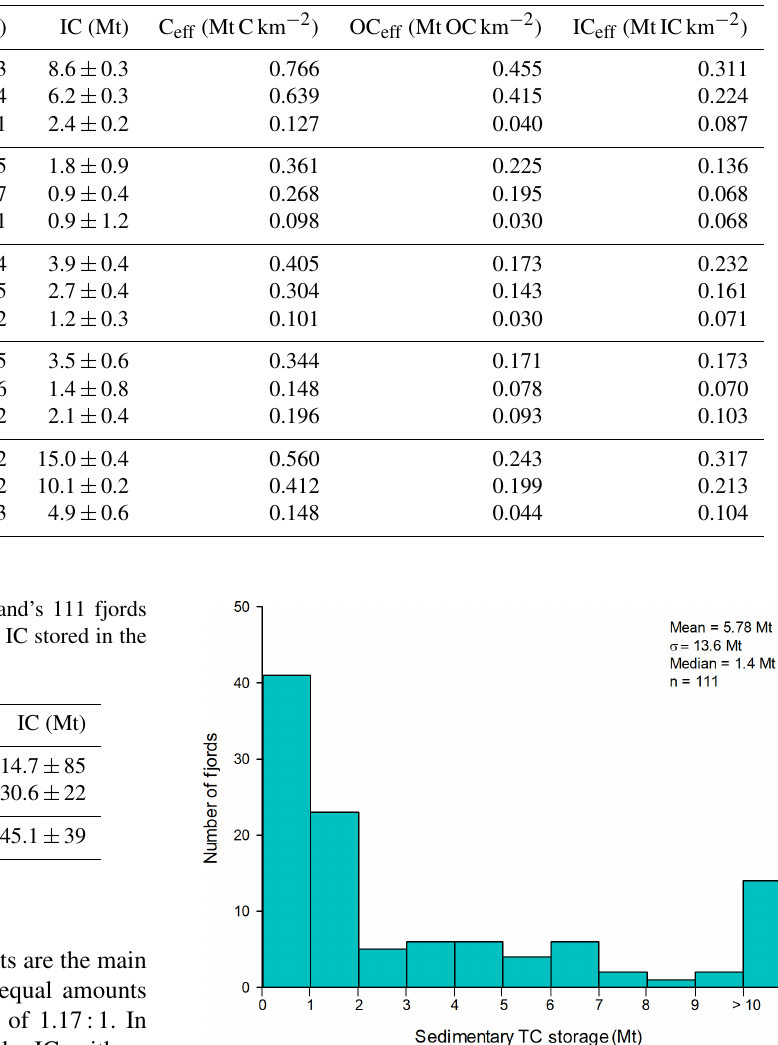
Table 2. Detailed sedimentary C stocks presented as total carbon (TC), organic carbon (OC) and inorganic carbon (IC) held within the postglacial (PG) and glacial (G) sediment of the fjords. Additionally, we list the C eff for each fjord as a measure of how effectively the sediment stores C.